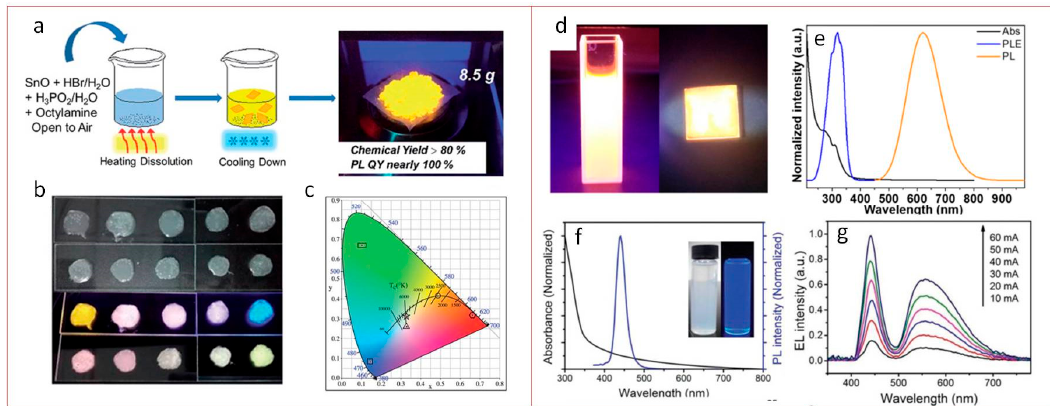
Figure 4. Lead-free perovskite nanomaterials based down-conversion LEDs. ( a ) Schematic representation of the synthesis of the 2D (OCTAm) 2 SnBr 4 by a facile aqueous acid-based synthetic method in ambient air. ( b ) Images of yellow phosphors, blue/green phosphors, and their blends with different ratios embedded in PS films under sunlight (top panel) and 365 nm UV light (bottom panel). The first row in each panel are a yellow–blue phosphor mixture, and the second is a yellow–blue–green mixture. ( c ) Chromaticity coordinates of different ratios of the phosphor mixture plotted on the CIE1931 chromaticity chart: Blue phosphor (square), yellow phosphor (round), yellow–blue phosphor 4:1 (triangle), and yellow–blue–green phosphor 4:1:1.5 (star). Reproduced with permission [76]. Copyright Royal Society of Chemistry, 2019. ( d ) Photograph of the colloidal suspension and film of (OAm) 2 SnBr 4 perovskites under UV light. ( e ) Normalized absorption (Abs), PL excitation (PLE, monitored at 620 nm), and PL (excited by 365 nm) spectra of the (OAm) 2 SnBr 4 perovskite film. Reproduced with permission [75]. Copyright American Chemical Society, 2019. ( f ) Absorption and photoluminescence spectra of CsBr:Eu 2+ NCs. The inset depicts the optical images of the NCs dispersed in hexane with and without illumination by a 365 nm UV lamp. ( g ) EL spectra and of the white LED operated under different forward bias currents. Reproduced with permission [77].